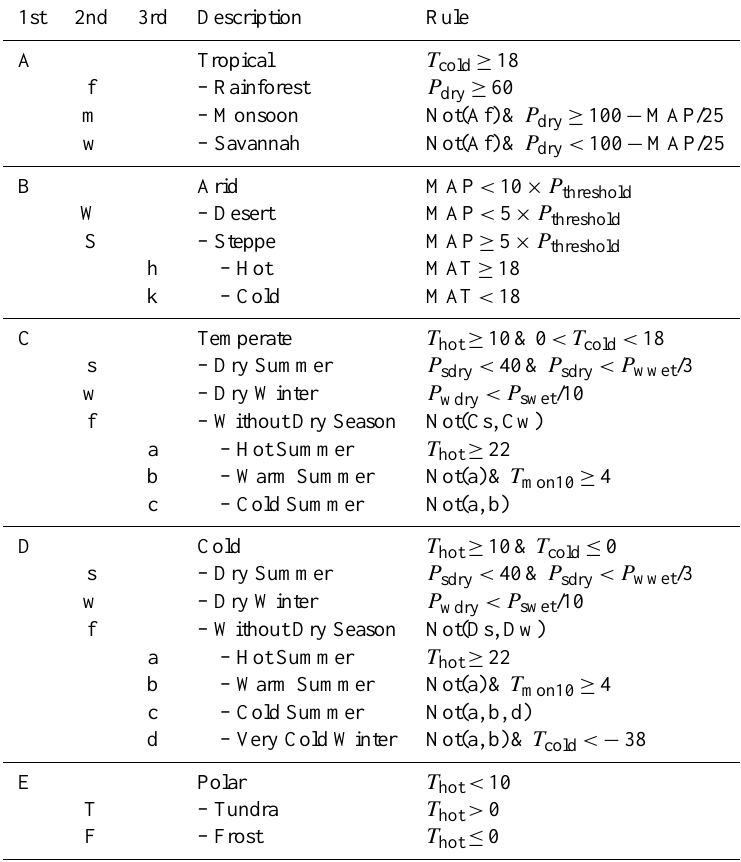
Table 1. K¨oppen-Geiger climate variables and classification rules (after Peel et al., 2007 and Kottek et al., 2006). Rules for climate class E must be applied first, then those for class B, and finally those for classes A, C, and D. For locations that satisfy both Cs and Cw (or Ds and Dw) rules, the w classification is applied if summer precipitation exceeds winter precipitation. In the following, temperature variables are measured in ◦ C, precipitation variables are measured in mm, and summer/winter is defined as the warmer/cooler of the six month period of October-March/April-September. MAP=mean annual precipitation; MAT=mean annual temperature; T hot =temperature of the hottest month; T cold =temperature of the coldest month, T mon10 =number of months above 10 ◦ C; P dry =precipitation of the driest month; P sdry =precipitation of the driest month in summer; P wdry =precipitation of the driest month in winter; P swet =precipitation of the wettest month in summer; P wwet =precipitation of the wettest month in winter; P threshold =precipitation threshold, which varies according to the fol- lowing rules: if 70% of MAP occurs in winter, then P threshold =2 × MAT, if 70% of MAP occurs in summer, then P threshold =2 × MAT+28, otherwise P threshold = ×